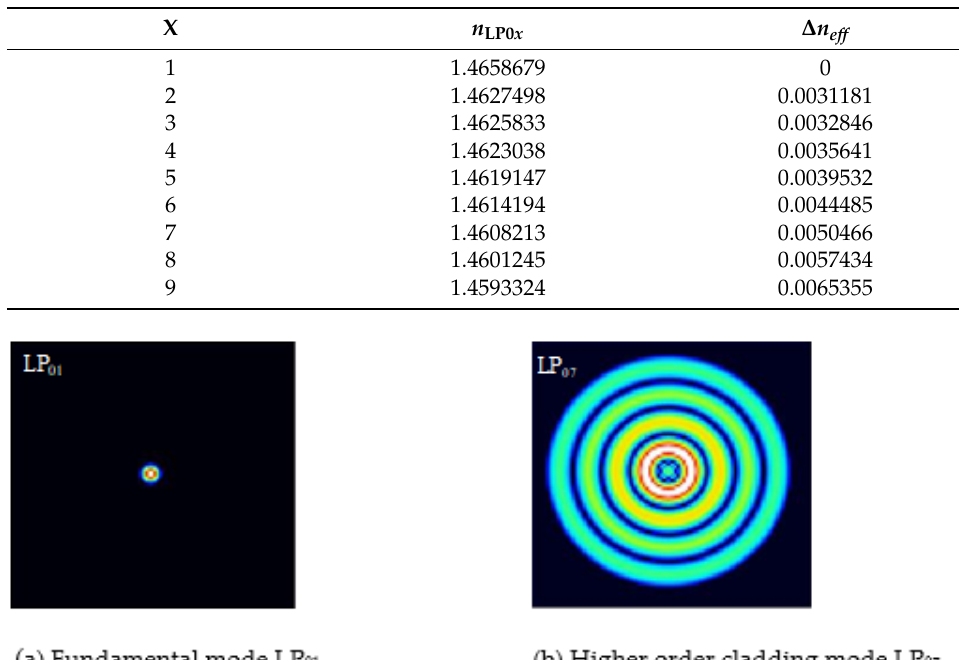
Table 1. Relationship between mode order and refractive index difference Δ n eff.